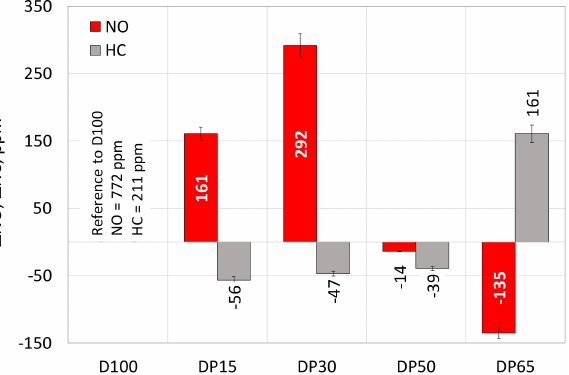
Figure 9. Emission of NO and HC for dual-fuel engine fueled by diesel and